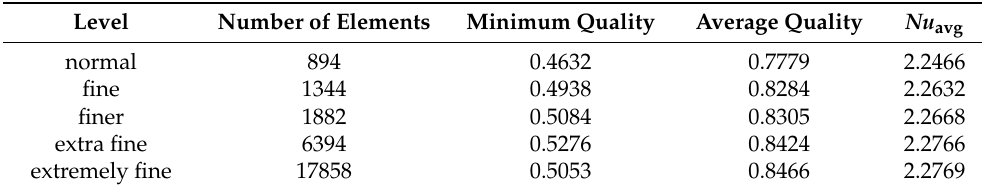
Figure 2. Grid generation of the structure with a legend of quality measure. Table 3. Comparison of the average Nusselt number for Cu nanofluid at different levels when φ = 0.5,